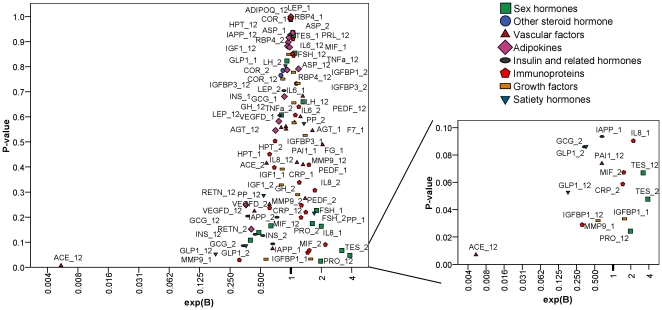
The predicting power of blood analytes for weight loss maintenance by Logistic Regression.Volcano plot of the significance P-value versus odd ratio exp(B) of blood proteins/steroids for predicting continued weight loss during the 6-month maintenance period by logistic regression controlled for age and the fold change of weight. The symbols of the analytes are listed in Table 1. Suffix “_1”: concentration at CID1, “_2”: concentration at CID2, “_12”: the fold change of concentration CID2/CID1. The analytes are grouped as in Table 1 and marked in different shape/color.